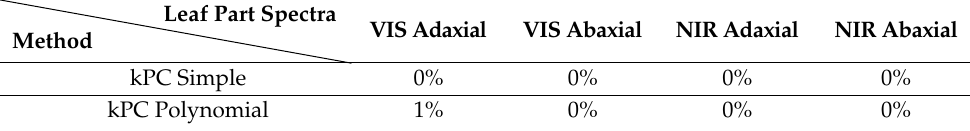
Table 6. Common classification error (e, %) for a linear discriminant classifier.